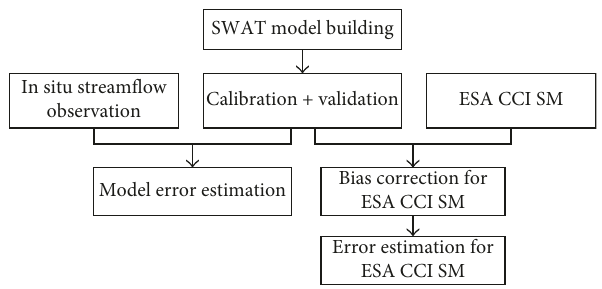
Figure 3: Flow chart for implementing ESA CCI SM assimilation in